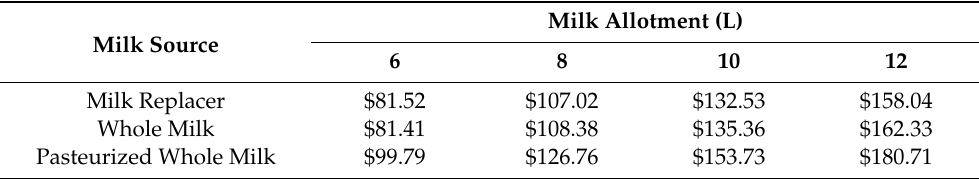
Table 4. Cost of milk replacer, whole milk, and pasteurized whole milk as a milk source for calves with 6, 8, 10, and 12 L milk allowances.